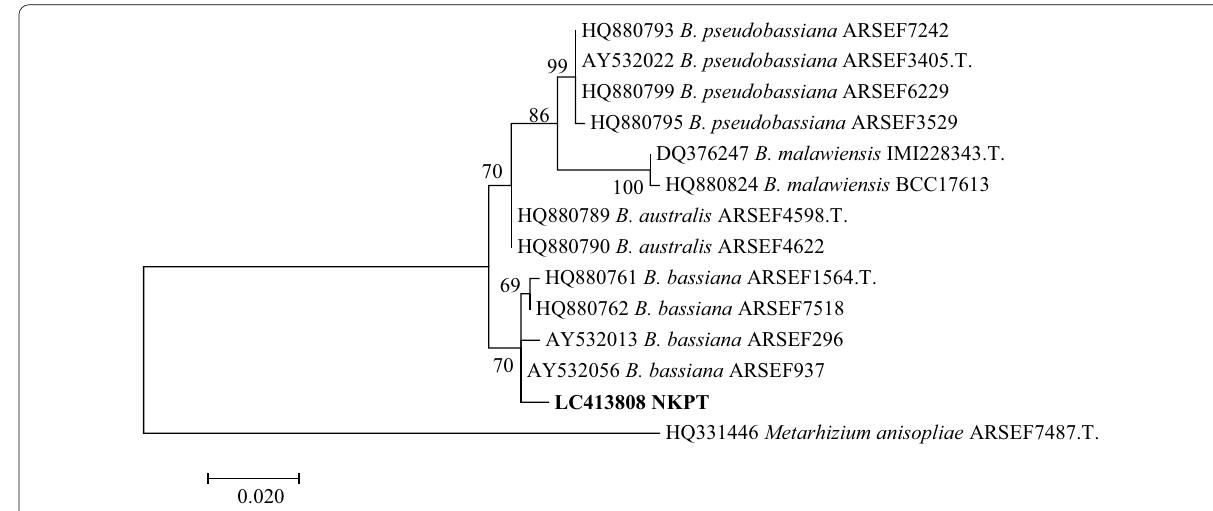
Fig. 3 Phylogenetic tree developed based on sequence analysis of ITS region by primer ITS1 and ITS4 with Maximum Likelihood method (Tamura– Nei model) created using MEGA7 for windows (Kumar et al. 2016). NKPT isolate placed within group of ex type and reference strains of Beauveria bassiana , i.e., ARSEF3405.T. (Acc. No. AY532022), ARSEF937 (Acc. No. AY532056), isolate ARSEF296 (Acc. no. AY532013) and ARSEF7518 (Acc. No. HQ880762). NKPT has other designations as B1_UNILA. Metarhizium anisopliae ARSEF7487.T. (Acc No. HQ331446) was used as out group. Reference